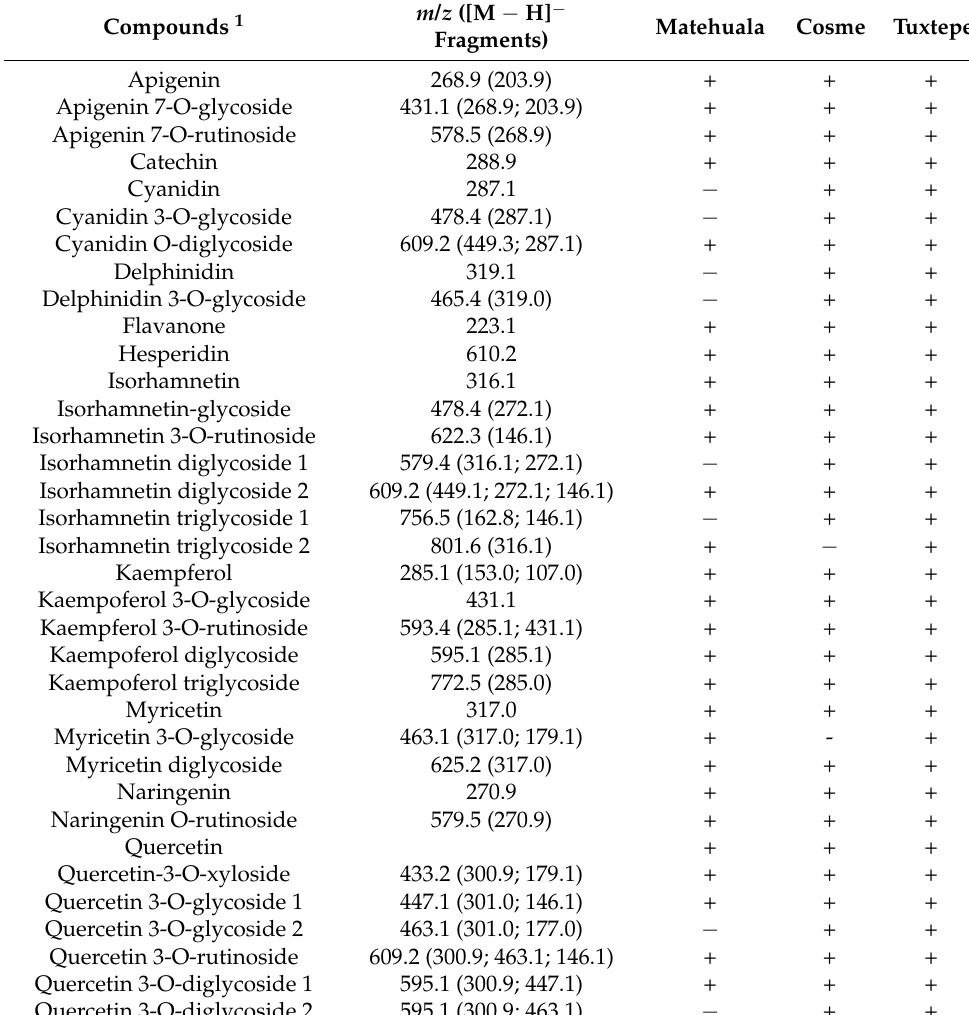
Table 2. Qualitative profile of flavonoid compounds in guishe ethanolic extract. Experimental m / z and major fragments were obtained by HPLC-MS analysis in negative polarity ([M − H] − ). Compounds